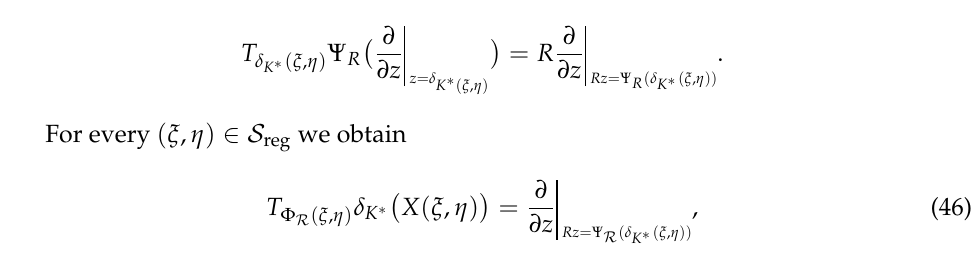
. ( center ) The points c , c (cid:48) and d , d (cid:48) in K ∗ are identified, 1,1,1 S reg = ( K ∗ \ { O } ) ∼ / G on a smooth 2-torus less three